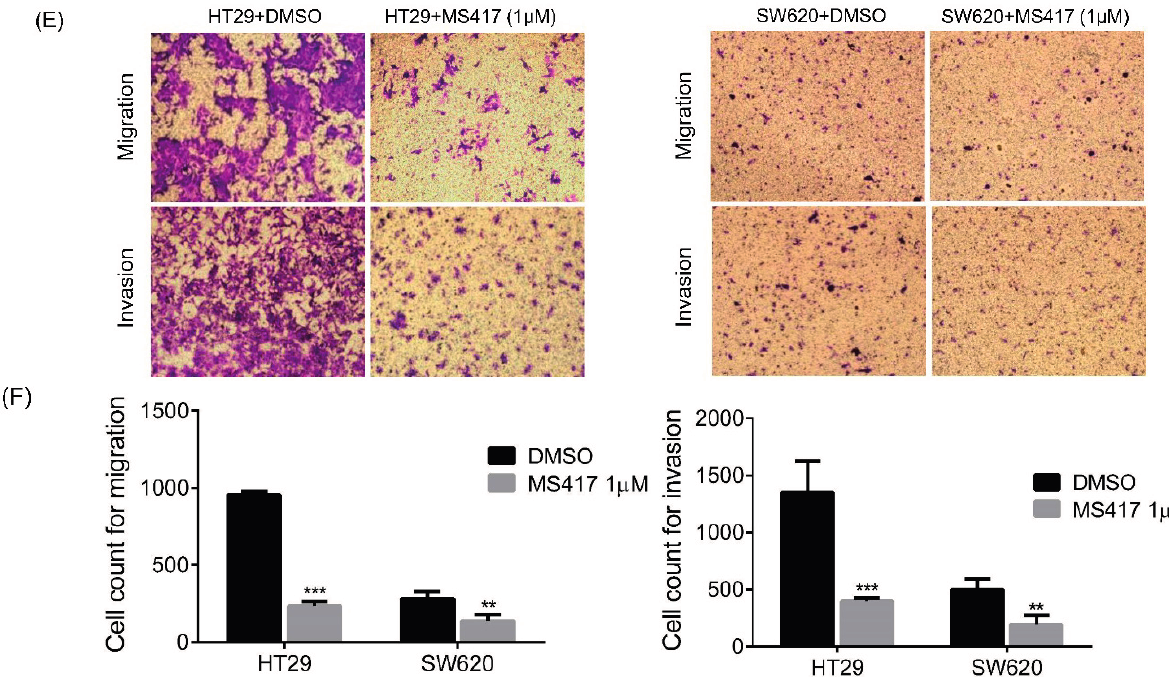
Figure 2. BRD4 inhibition attenuates proliferation, migration and invasion in vitro . ( A ) 72 h survival rate curve of HT29, HCT8, HCT116, SW480 and SW620 treated with vehicle (DMSO) or MS417 (1, 3, 6, 9, 12, 24, 30 µM), measured by MTT; ( B ) IC 50 of HT29, HCT8, HCT116, SW480 and SW620 following vehicle/MS417 for 24, 48 and 72 h; ( C , D ) macroscopic and microscopic images and quantification of colonies formed by HT29 or SW620 cell lines treated with MS417 (1 µM); ( E , F ) Cell migration and invasion of HT29 or SW620 cell lines were inhibited by MS417 (1 µM). n = 3 repeats with similar results. ** p < 0.01; *** p < 0.001. Values are depicted as Mean ±